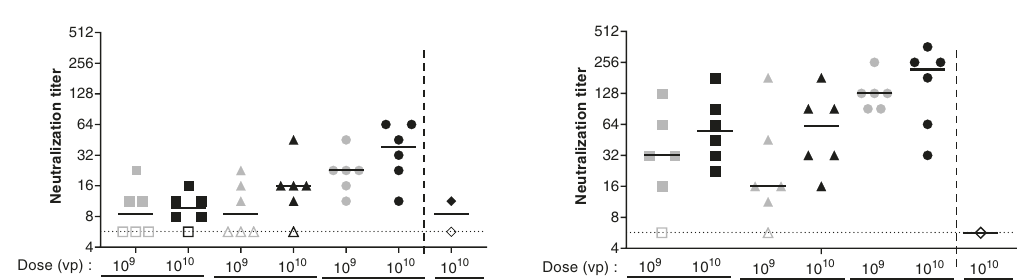
Fig. 2 SARS-CoV-2 neutralizing antibody response elicited by one- and two-dose Ad26.COV2.S vaccine regimes in Syrian hamsters. a Syrian hamsters were immunized with either 10 9 or 10 10 VP ( N = 12 per dose level) of Ad26-based vaccines, or with 10 10 VP of an Ad26 vector without gene insert as control (Ad26.empty, N = 6). Four weeks after immunization half the hamsters per group received a second immunization with the same Ad26-based vaccine ( N = 6 per group). b SARS-CoV-2 neutralization titers were measured 4 weeks after dose 1 and c 4 weeks after dose 2 by wild-type VNA determining the inhibition of the cytopathic effect of SARS-CoV-2 on Vero E6 cells. The sera from Syrian hamsters immunized with Ad26.Empty were pooled into two groups for negative control samples. Median responses per group are indicated with horizontal lines. Dotted lines indicate the LLOD. Animals with a response at or below the LLOD are displayed as open symbols on the LLOD. CPE cytopathic effect, LLOD lower limit of detection, p.i. post inoculation, VNA virus neutralization assay, VP virus detectable viral load for both vaccine dose levels, suggesting no To determine the impact of the vaccines on viral load in the added value of the second dose. Viral load in the animals with upper respiratory tract, nasal turbinate viral load was determined breakthrough infections were also similar to the viral load in after sacri fi ce at 4 dpi, and throat swab viral load was determined animals with breakthrough infections after one vaccination. A daily after infection and was analyzed as area under the curve second dose of 10 9 VP Ad26.S or Ad26.dTM.PP also had little (AUC) per animal up to day 4 post infection. In animals receiving a impact on the lung infection rate post challenge at week 8 ( fi ve single vaccine dose, a limited but statistically signi fi cant reduction out of six animals showed detectable viral load per vaccine, in nasal turbinate viral load after challenge was observed for Ad26. median titer 10 4.9 and 10 6.7 TCID 50 /g, respectively) but a second dTM.PP but not for Ad26.COV2.S and Ad26.S compared with the dose of 10 10 VP of these prototype vaccines was associated with a control group. After two vaccine doses, all three vaccines induced lower lung infection rate and median lung viral loads compared a signi fi cant reduction in nasal turbinate viral load post challenge with the one-dose regimens (median titer 10 2 and 10 4 TCID 50 /g, compared with the Ad26.Empty group (Fig. 3c, d). By contrast, respectively), suggesting a bene fi t of a two-dose regimen (Fig. 3b). throat swab viral load data show that none of the vaccines